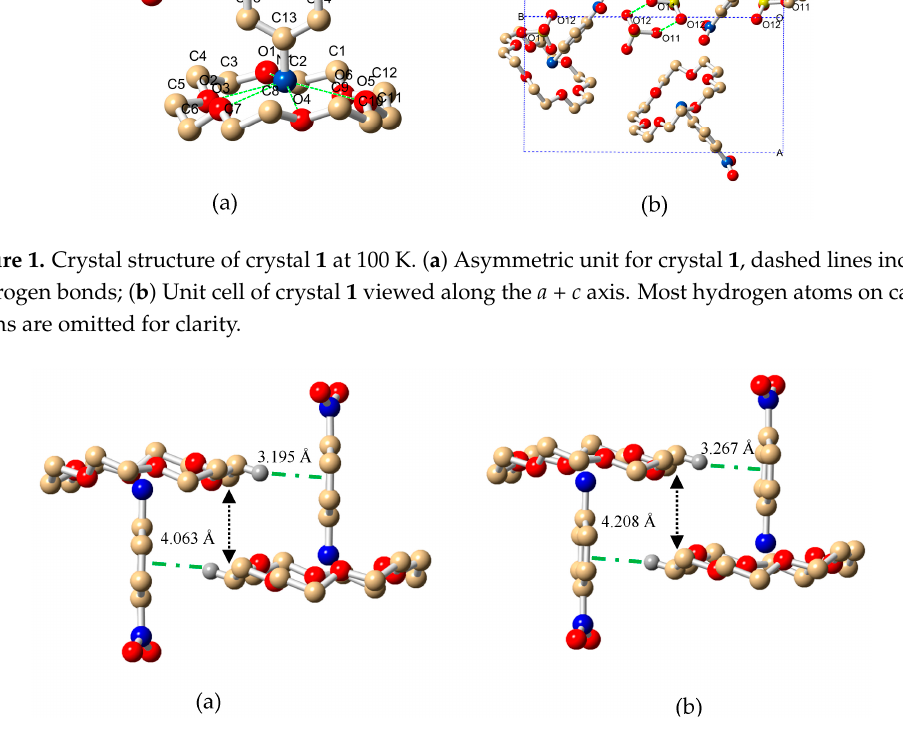
( b ) Figure 3. Asymmetric unit ( a ) and packing diagram ( b ) of crystal 2 viewing along the a -axis at 100 K and 296 K. Most of the hydrogen atoms on the carbon atoms are omitted for clarity. The most striking structural features in the LTP and HTP forms were the distances of the two crown ether rings. The distances of crystal 2 from the neighboring [(4-HNA)(18-crown-6)] + supramolecular cations were 8.877 Å (100 K) and 9.082 Å (296 K) (Figure 4). Interestingly, it was found that obvious disorder phenomena occur in the HTP phase of the –NO 2 group. The O 14 , O 15 , O 16 , O 17 atoms of –NO 2 group in supramolecular cations are distinctly disordered and occupy two sites (O 14A , O 14B , O 15A , O 15B , O 16A , O 16B , O 17A , O 17B ). The occupation factors of oxygen atoms of –NO 2 group are displayed in Table S2, suggesting that biased –NO 2 group orientation was achieved in compound 2 (Fig 4b). The –NH 3 ﹢ group resided in a perching position, and attained a configuration similar to that of crystal 1 ; the group was linked by the oxygen atoms of the crown ethers through